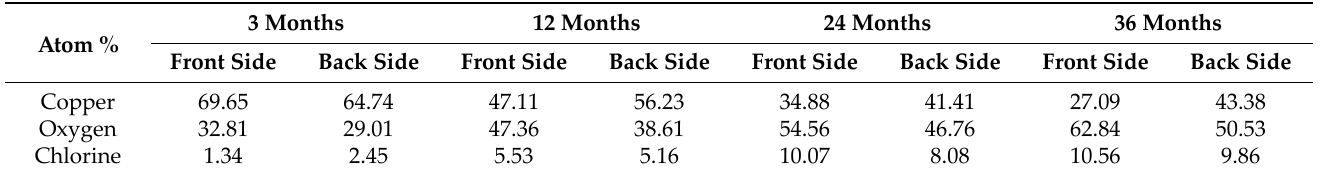
Table 2. EDS of the copper corrosion product at different exposure times. 1000 × .